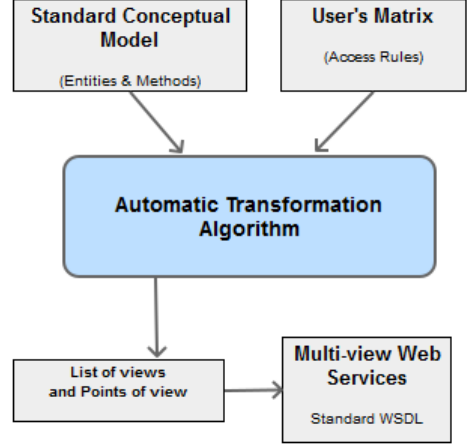
Fig. 1. Automatic transformation